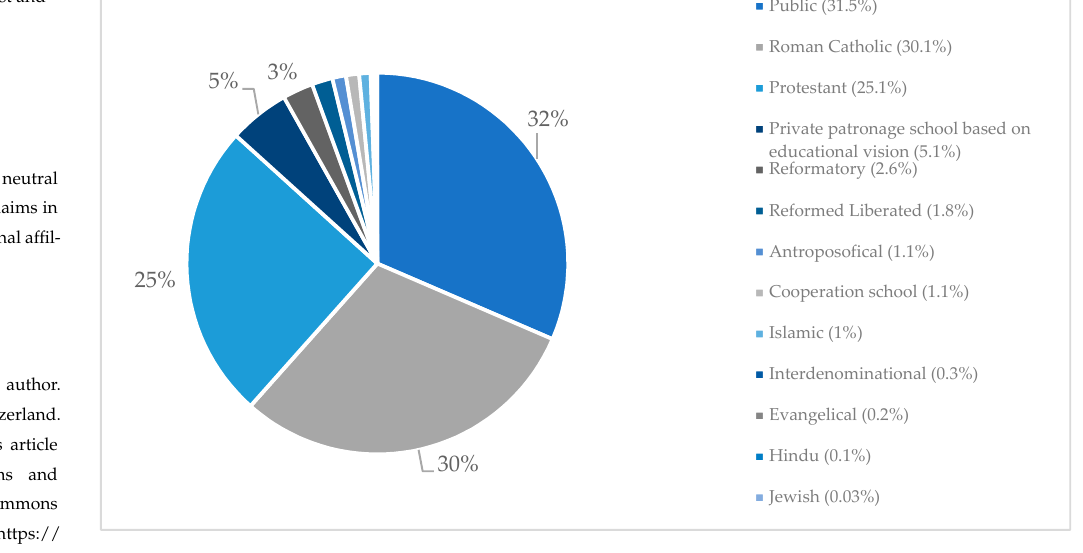
Figure 1. Number of primary schools in the Netherlands by denomination (3 January 2022) (based on Dienst Uitvoering Onderwijs 2022).